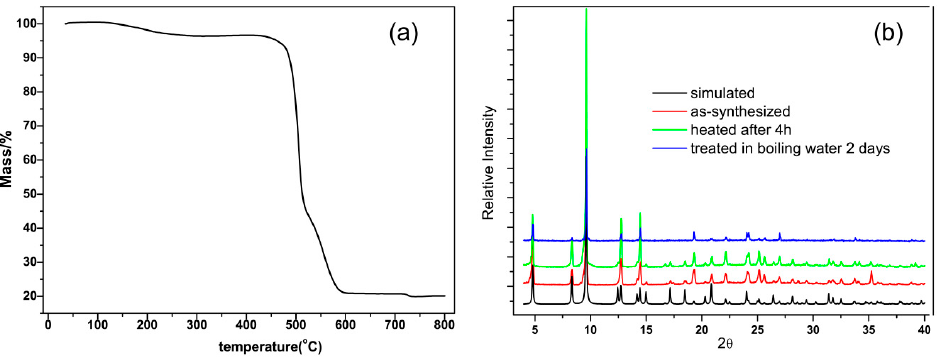
Figure 2. ( a ) TGA curve of Zn(hfipbb) in air; ( b ) PXRD patterns of Zn(hfipbb).